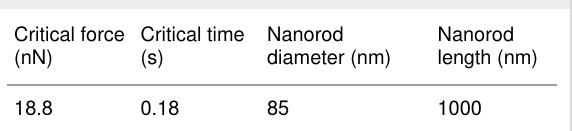
Table 10: Employed information by Moradi et al. [8].